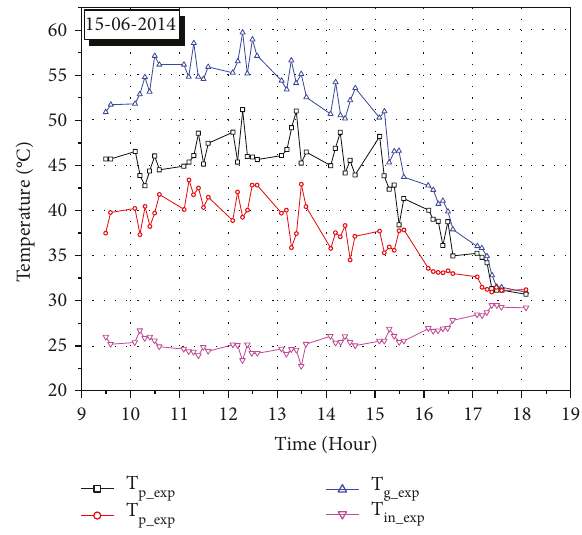
Figure 8: Hourly variations of the inlet and outlet air temperatures of the PV/T collector.